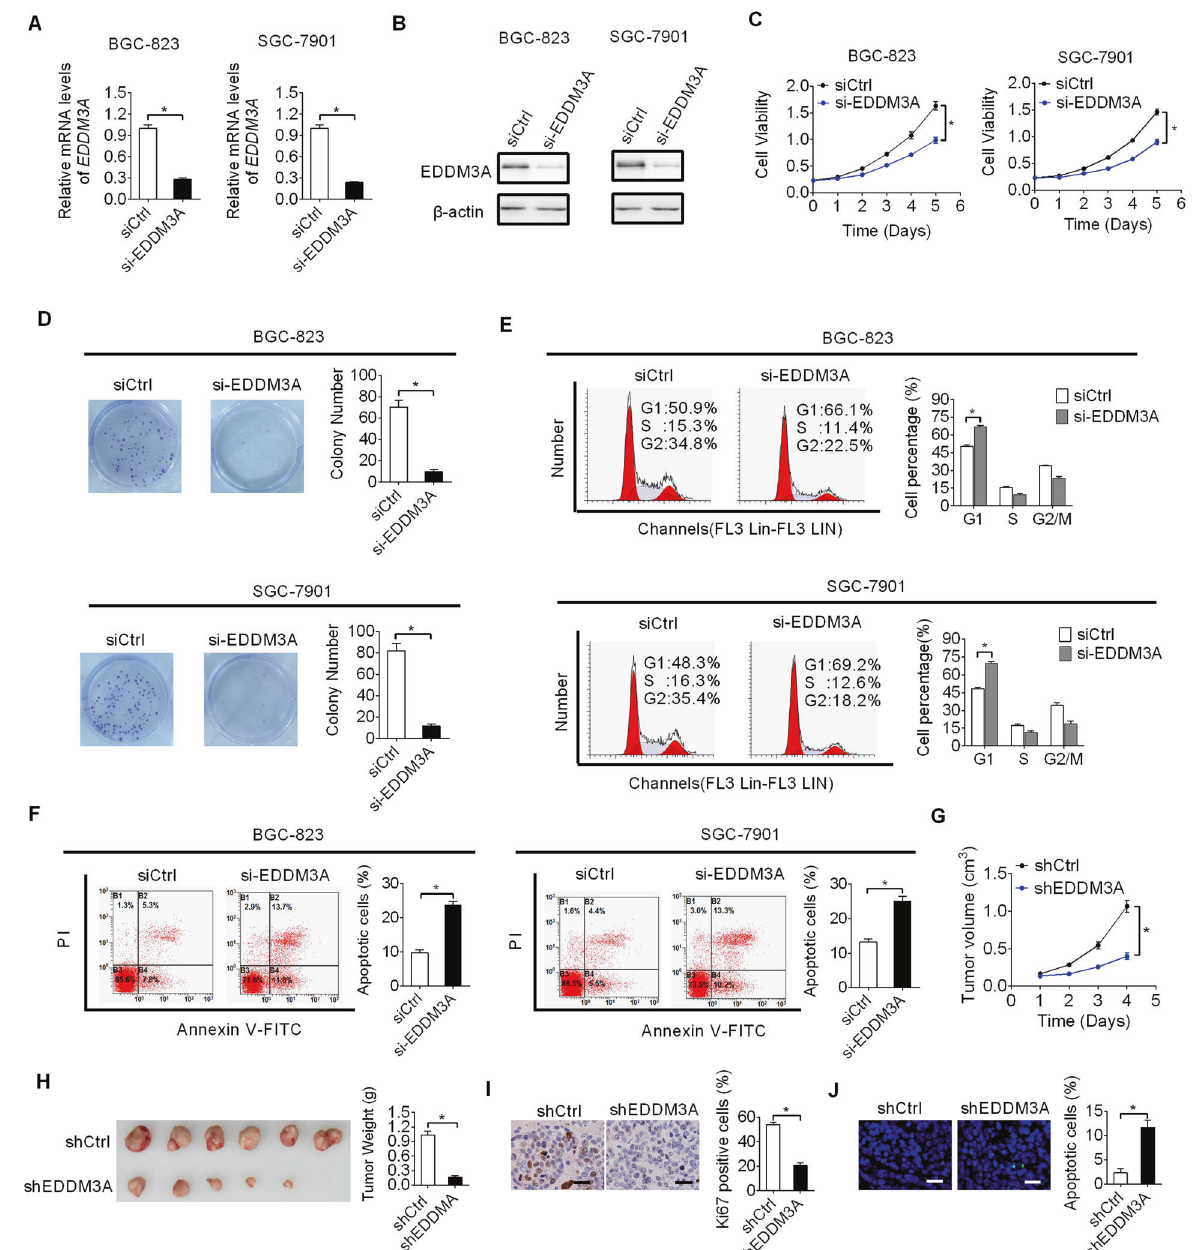
Fig. 2 Knockdown of EDDM3A suppressed GC growth via inducing cell cycle arrest and apoptosis. A , B Knockdown of EDDM3A was detected using qRT-PCR and Western blot analysis in BGC-823 and SGC-7901 cells. C , D Effects of EDDM3A knockdown on cell viability and colony formation abilities were evaluated in BGC-823 and SGC-7901 cells. E , F Effects of EDDM3A knockdown on cell cycle progression and apoptosis were determined in BGC-823 and SGC-7901 cells. G In vivo tumor growth rates were compared between shEDDM3A and shCtrl groups. H Tumor size and weight were compared between shEDDM3A and shCtrl groups. I , J Ki-67 IHC staining and TUNEL assays were used for detection of cell proliferation and apoptosis in xenograft tumors. Scale bars, 20 μ qRT-PCR and western blot assays (Fig. 4A, B). Overexpression of EDDM3A signi fi cantly elevated the viability and colony forma- tion ability in AGS and MKN-45 cells, as demonstrated by MTS cell viability and colony formation assays (Fig. 4C, D). Additionally, overexpression of EDDM3A in AGS and MKN-45 cells also resulted in a remarkable increase of cell migration and invasion, as demonstrated by wound-healing and matrigel invasion assays (Fig. 4E, F). Altogether, the above results further con fi rm that EDDM3A is a novel oncogene involved in gastric carcinogenesis.